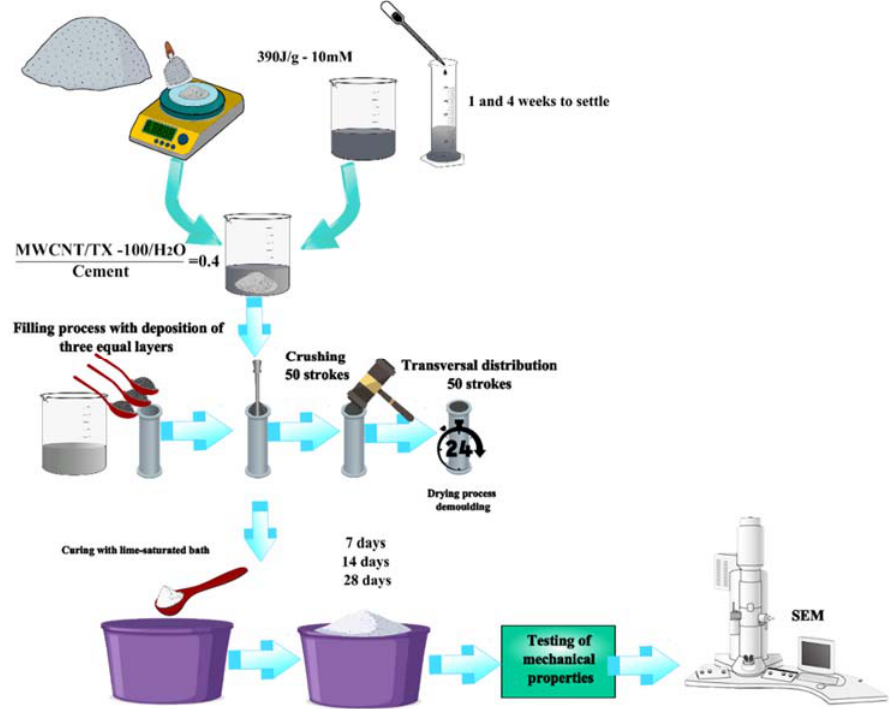
Figure 2. Scheme of the procedure to produce and analyze cement specimens with MWCNT solution dispersed at 390 J/g and with a molarity of surfactant of 10 Mm.